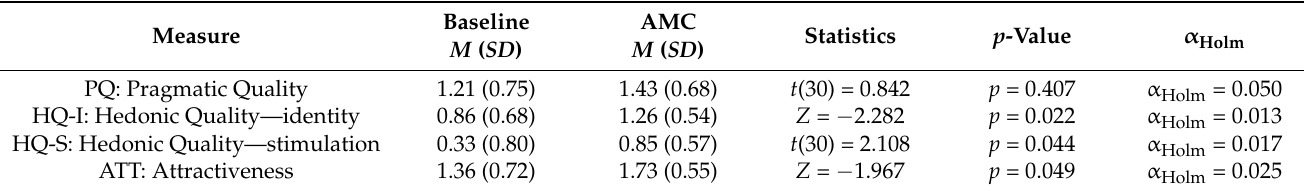
Table 4. Mean (and SD) values and statistics comparing subcategories of the AttrakDiff questionnaire.